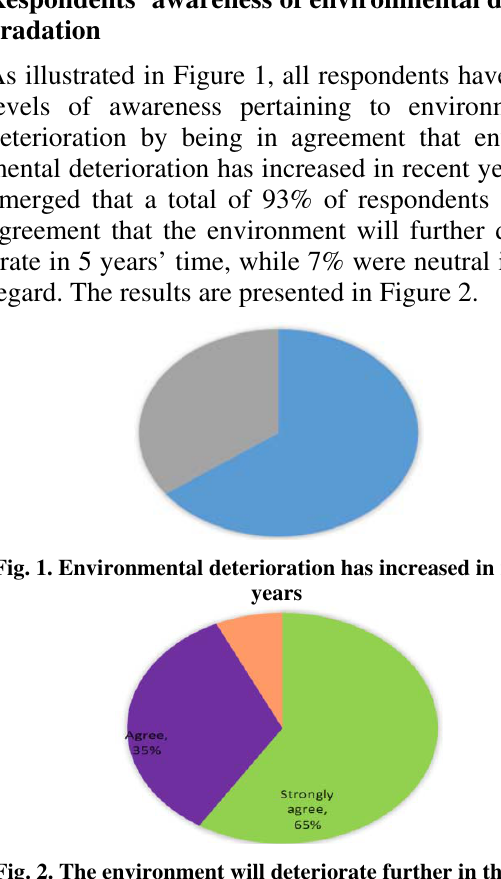
Fig. 2. The environment will deteriorate further in the